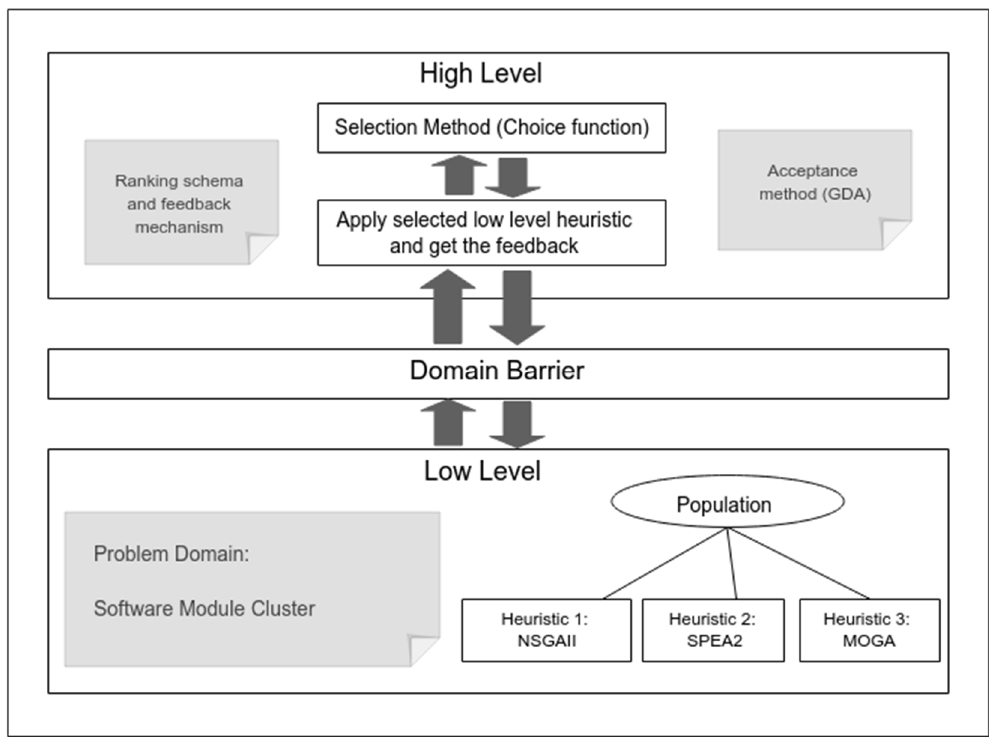
Figure 2. The multi-objective choice function-great deluge hyper-heuristic (HHMO_CF_GDA) framework. Readapted from [5].